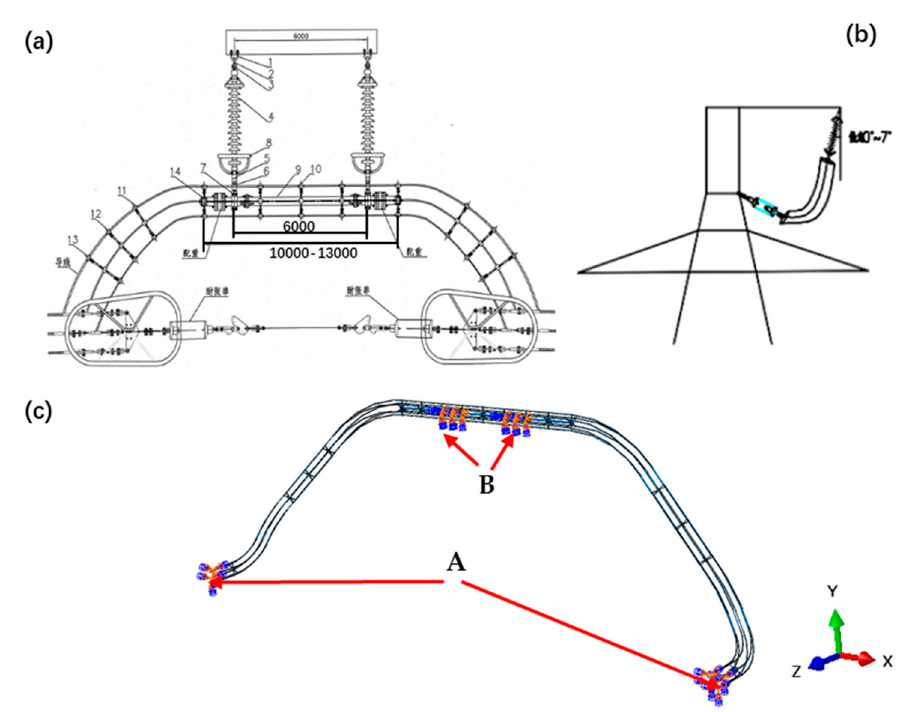
Figure 2. ( a ) Structural diagram of a mid-phase jumper, ( b ) side view of a mid-phase jumper on a tower, and ( c ) finite element model of a mid-phase jumper in Abaqus.